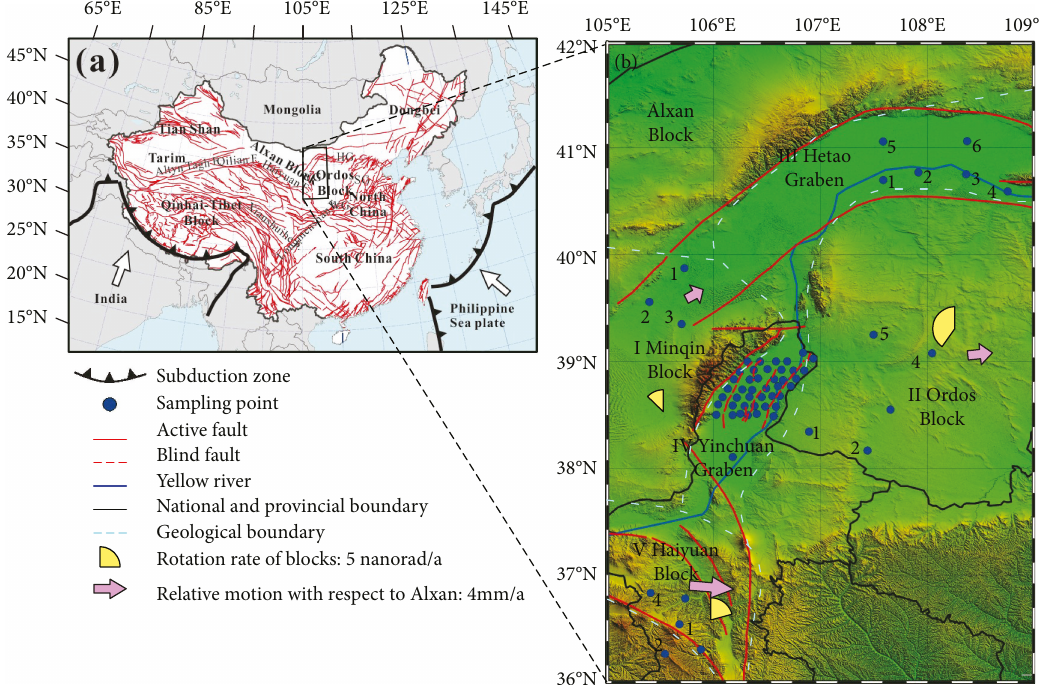
Figure 1: Topographic map showing active faults and sampling points near the western margin of the Ordos Block, China: (a) location of the study area (modi fi ed after [29]); (b) study area. Arabic numerals indicate the sampling point numbers in the di ff erent tectonic units: I: Minqin Block; II: Ordos Block; III: Hetao Graben; IV: Yinchuan Graben; V: Haiyuan